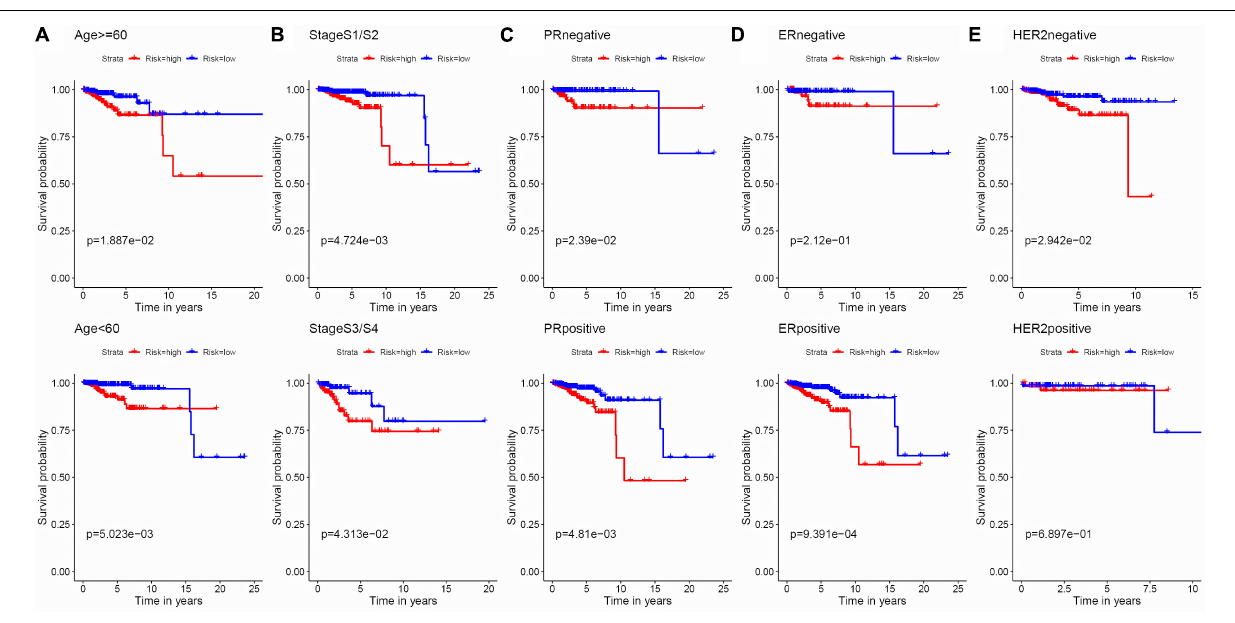
the training ( Figures 3A,D ), test ( Figures 3B,E ), and the whole sets ( Figures 3C,F ). Patients with different ages, stages, PR status, ER status, and Her2 status were stratified based on the risk levels,